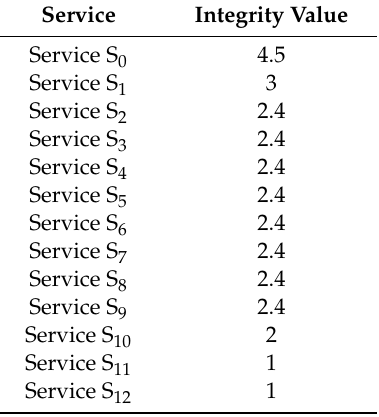
Table 10. Integrity values of service invocation elements in network reception and dispatch module.